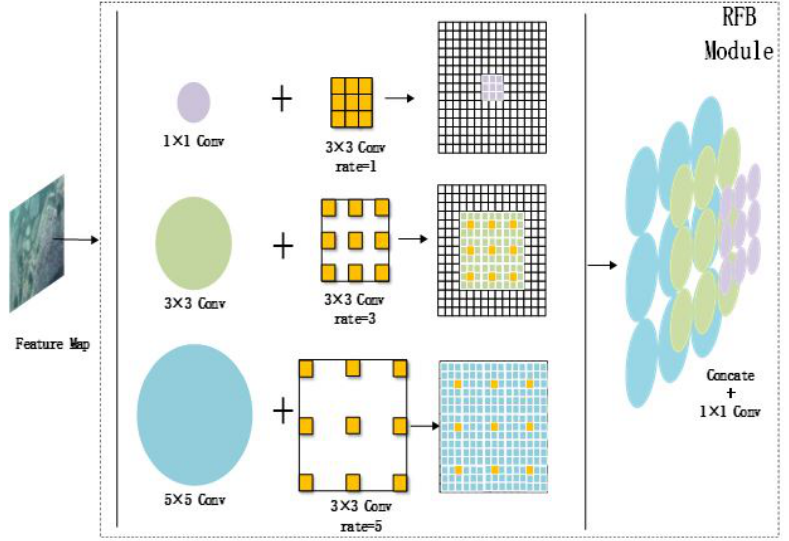
Figure 8. RFB module processing